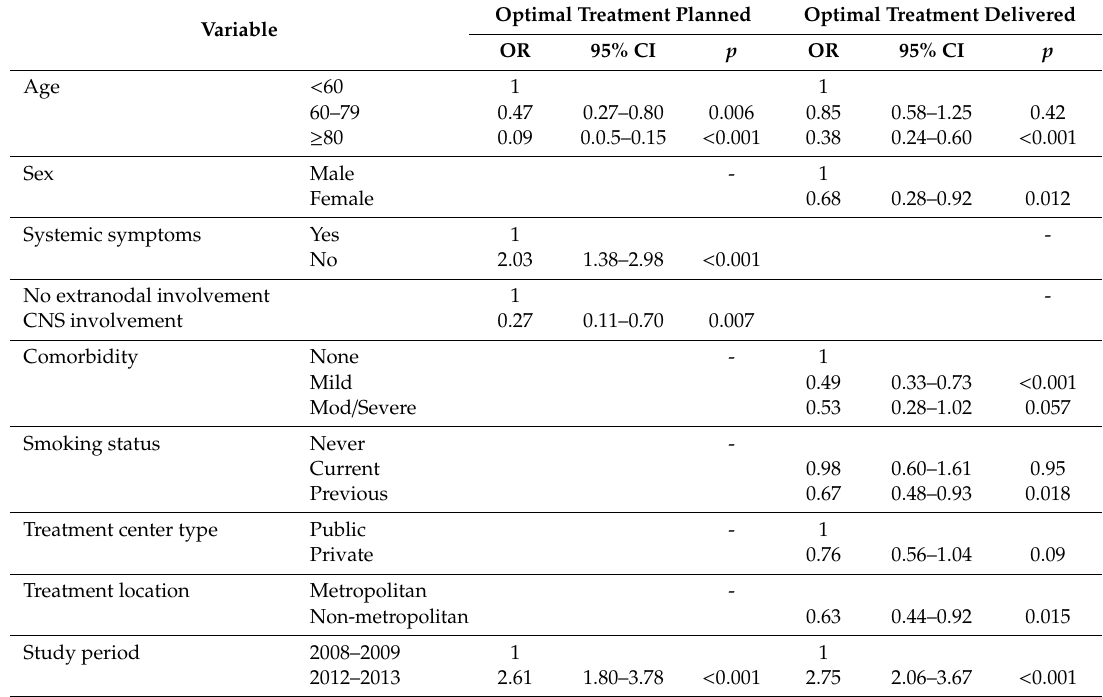
Table 3. Factors associated with optimal treatment (multivariable).